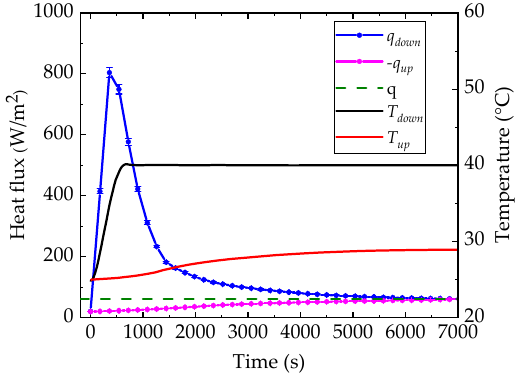
Figure 8. The curves of testing results of heat fluxes and temperatures.